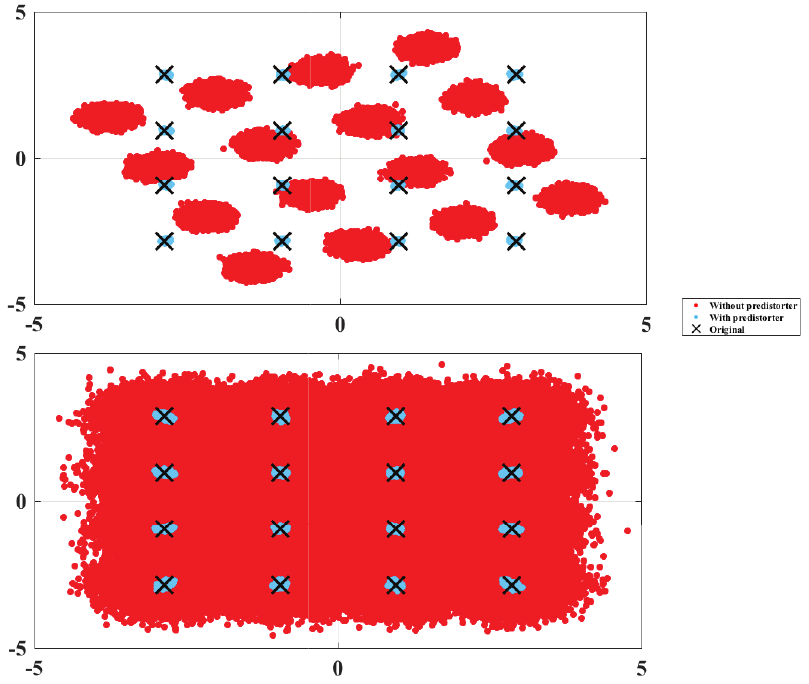
Figure 12. DCM Constellation—Before and after NN pre-distorters for TWTA ( up ) and SSPA ( down ), mean input power = 22.5